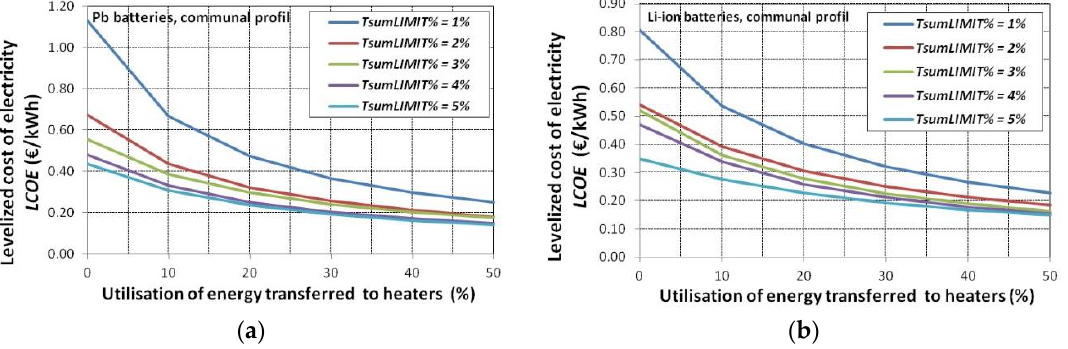
Figure 14. A change in the LCOE for optimum systems in the function of maximum time T sumLIMIT% and cases of the percentage use of energy emitted on the heaters during heating processes (communal profile, 50 kW peak power load): ( a ) lead-acid batteries; ( b ) lithium-ion batteries.